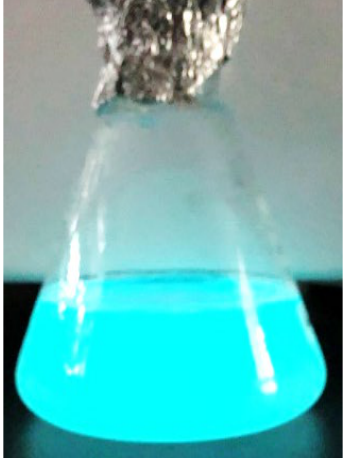
Figure 1. Bioluminescence of the bacteria suspension.